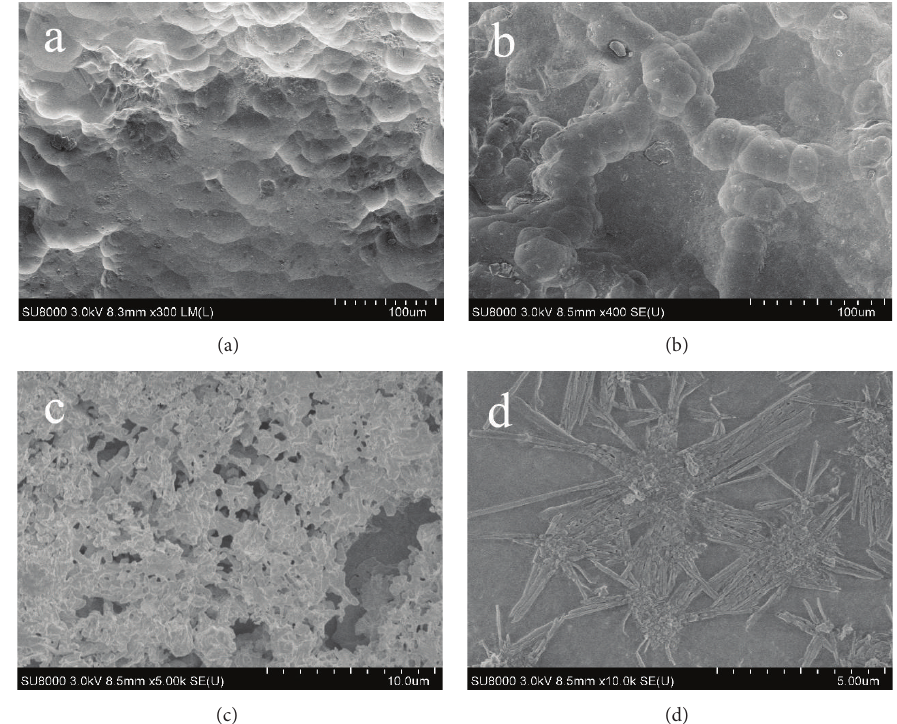
Figure 2: SEM images of surface of etched quartz column: (a) at low magnification, (b) at high magnification; SEM images of surface of 550-4: (c) at low magnification, (d) at high